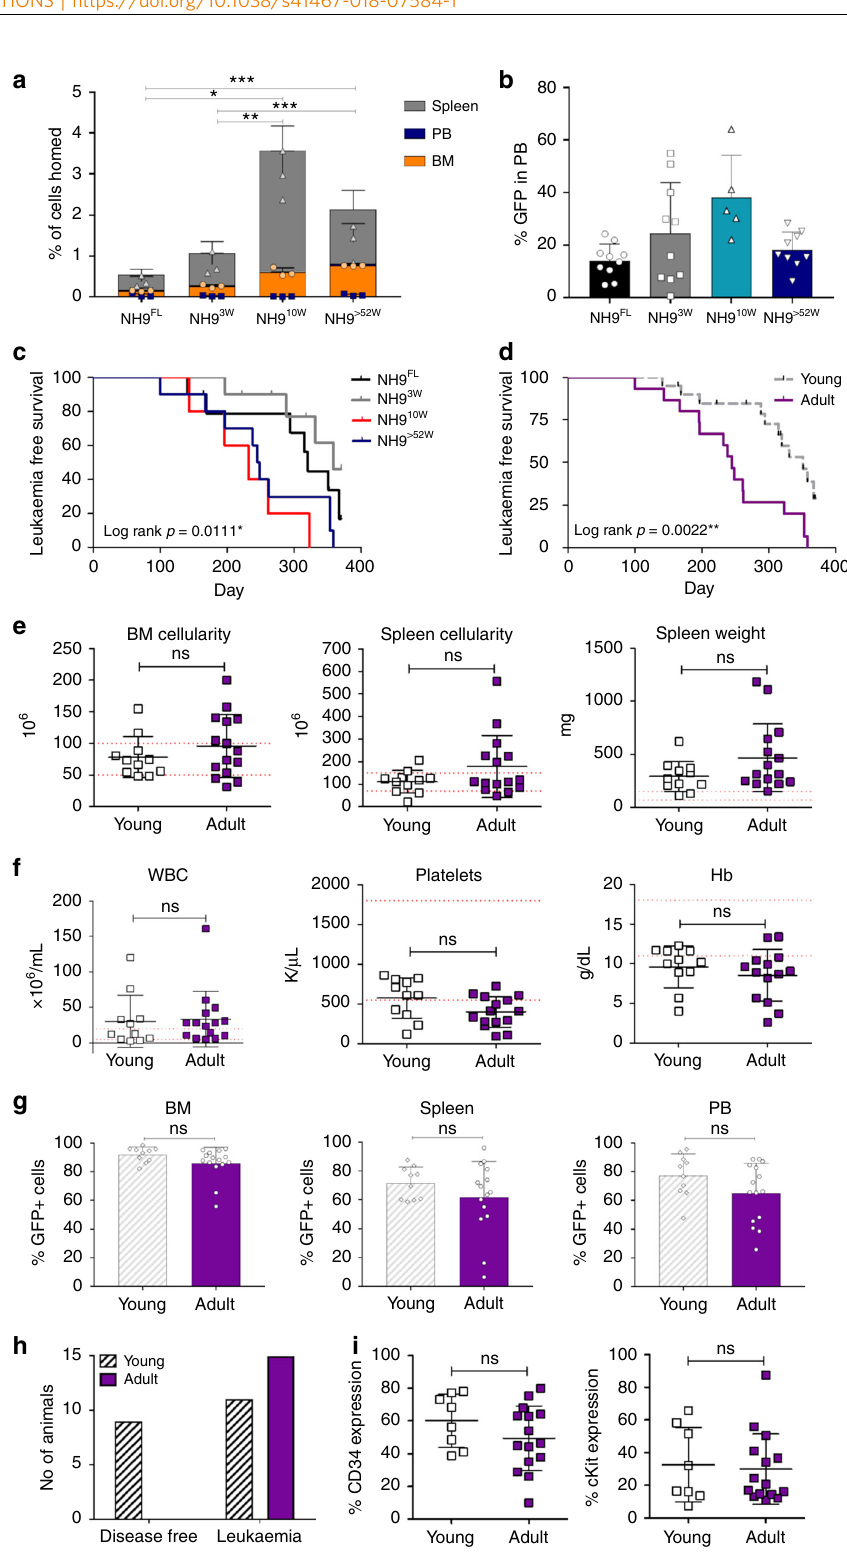
enriched immune response in NH9 10W leukaemic cells (Supple- mentary Figure 2d) and enrichment of cell – cell interaction pathways in NH9 >52W leukaemic cells (Supplementary Figure